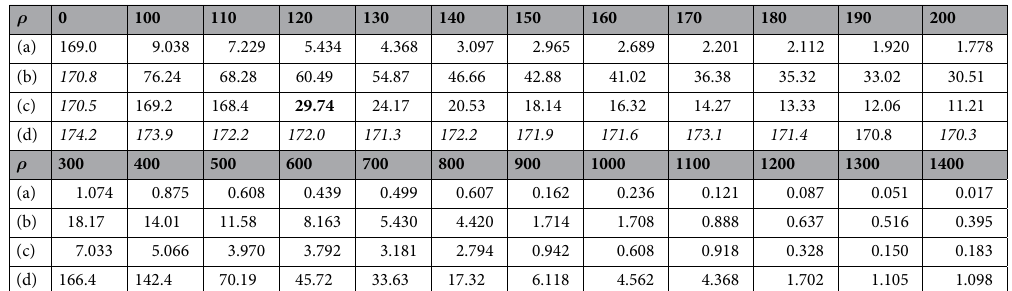
Table 3. SRFs of nanomotor in box filled with argon at different temperatures. (a) N = 2 & T = 100 K, (b) N = 2 & T = 300 K, (c) N = 7 & T = 100 K, and (d) N = 7 & T = 300 K. Units: ρ = Argon density: kg/m 3 , Rotational frequency: